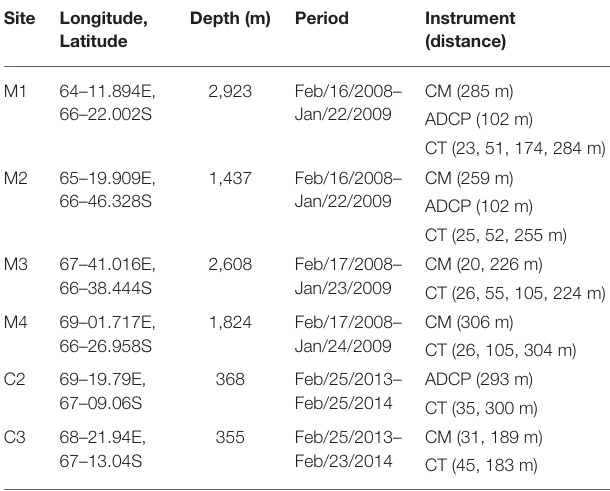
Acronyms CM, ADCP, and CT represent current meter, acoustic Doppler current profiler, and conductivity-temperature sensors, respectively. Numbers in parentheses in the last column indicate the distance of the instrument from the